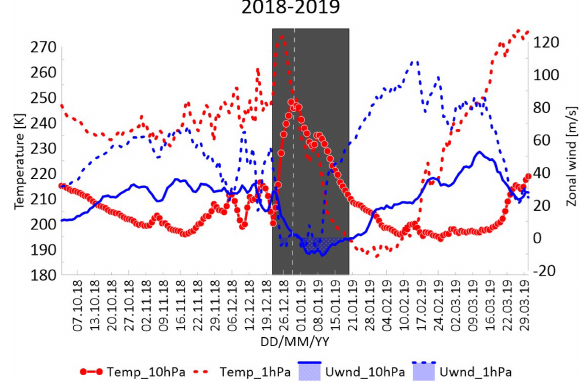
Figure 8. Same as Fig. 2 but October 2018 through March 2019.